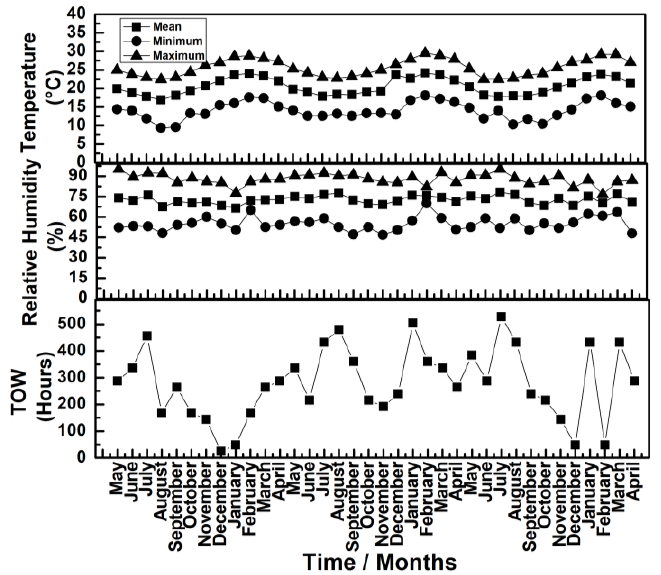
Figure 3. Variation of temperature, relative humidity, and wetting time during exposure (3 years).